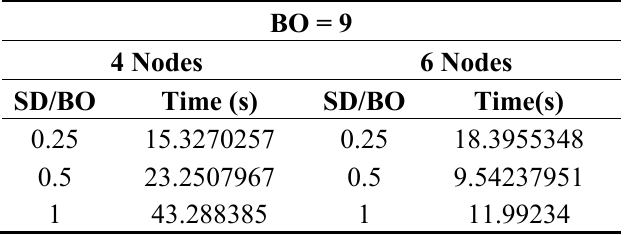
Table 6. Standard deviation of the set-up time samples. BO =